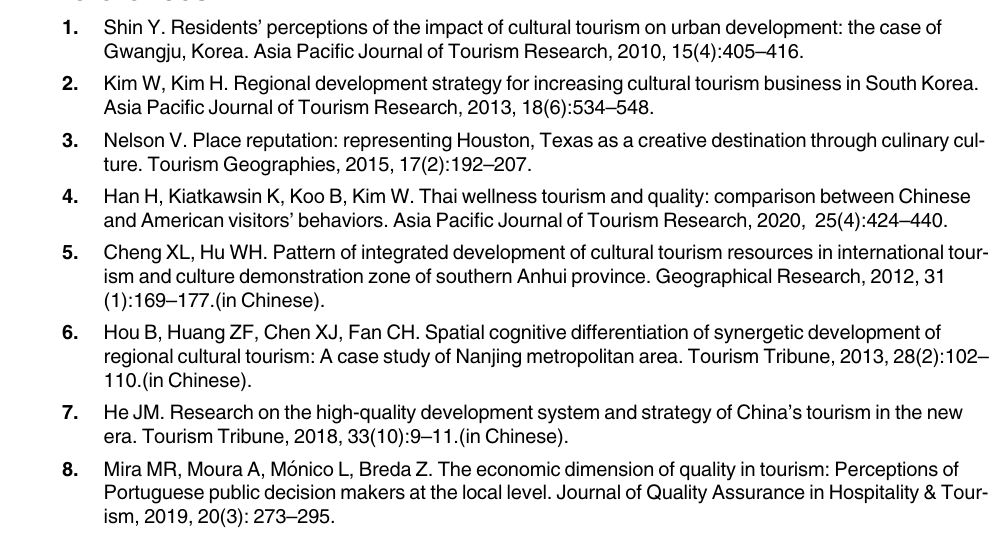
S6 Table. SDM results for HDCT. S7 Table. Decomposition results of spatial effect. S8 Table. Evolution types of